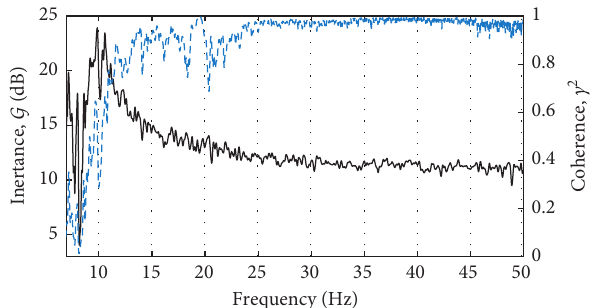
Figure 18: Inertance of the system, random input with amplitude 38m/s 2 RMS. Blue dotted line: coherence.